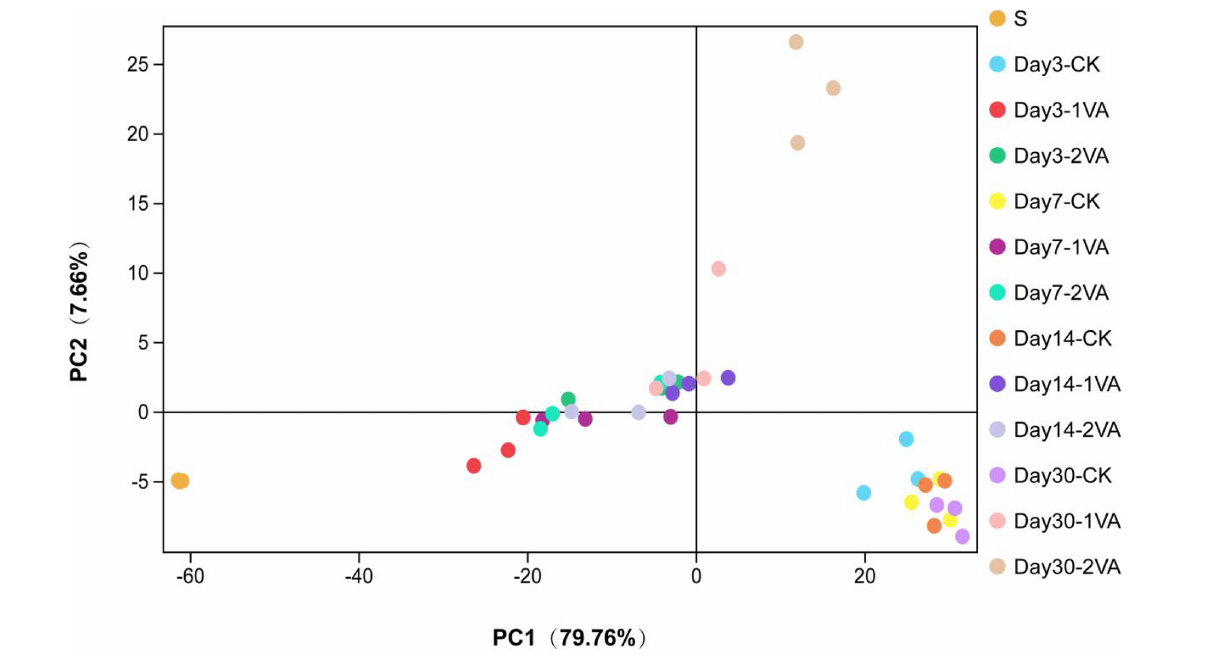
FIGURE 2 | Principal component analysis of bacterial community in stylo silage ensiled with the addition of vanillic acid (S: raw material, i.e., fresh stylo, CK: blank control, 1 and 2%: addition of 1 or 2% vanillic